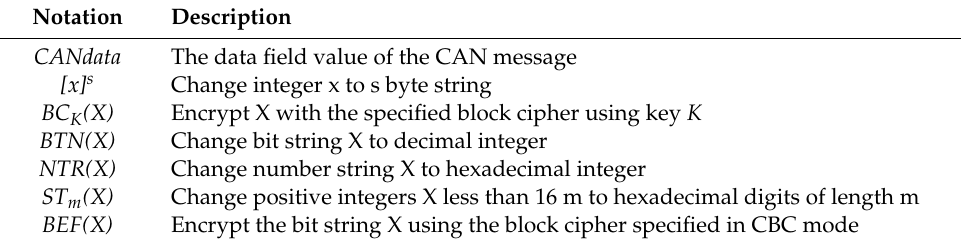
Table 4. Brief description of acronyms.